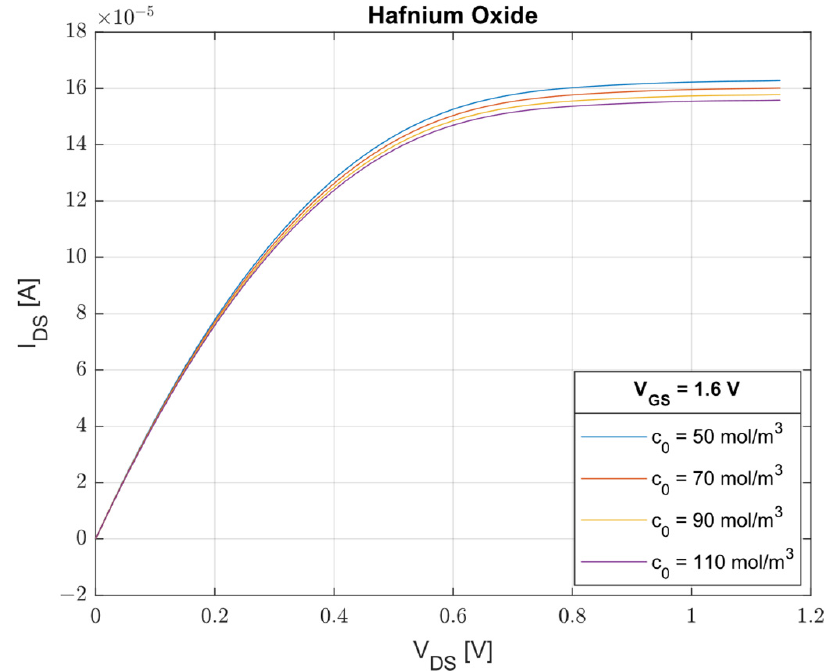
Figure 5. Optimal performances of ISFET: drain-source current vs. drain-source voltage for four different Cl − values using HfO 2 as the insulating layer.